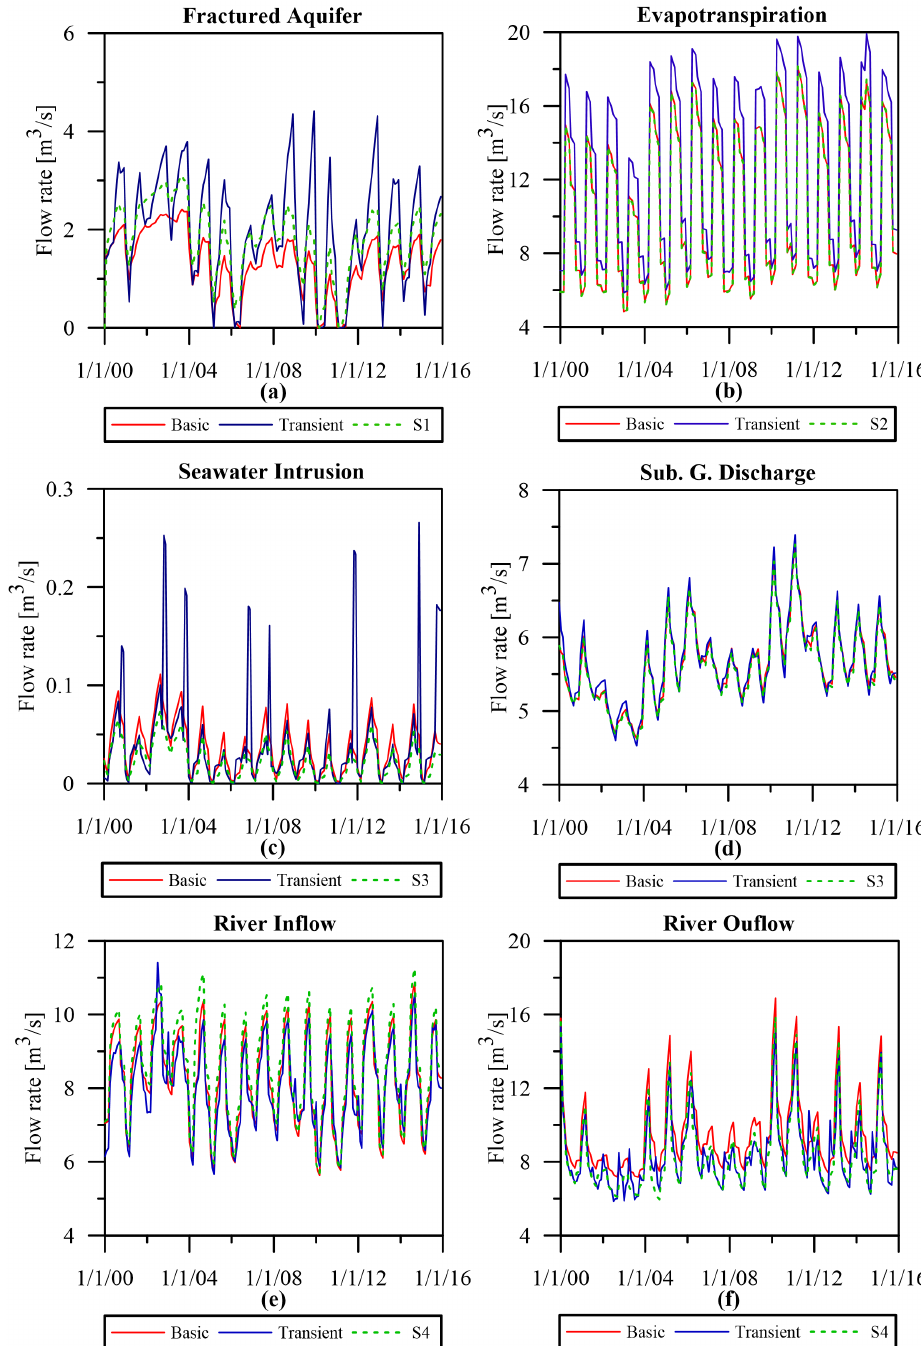
Figure 5. Comparison of the fluxes’ trends over the simulation time among the basic (red line), the transient (blue line) and the S1, S2, S3, and S4 (green dashed lines) simulations: ( a ) Inflow from the fractured aquifer, ( b ) Evapotranspiration, ( c , d ) Seawater intrusion and Submarine groundwater discharge, ( e , f ) River inflow and outflow.